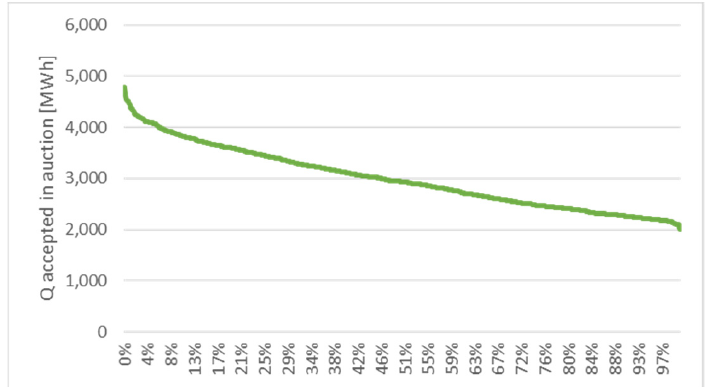
Figure 7. Duration curve of the quantity accepted in the RR auction.